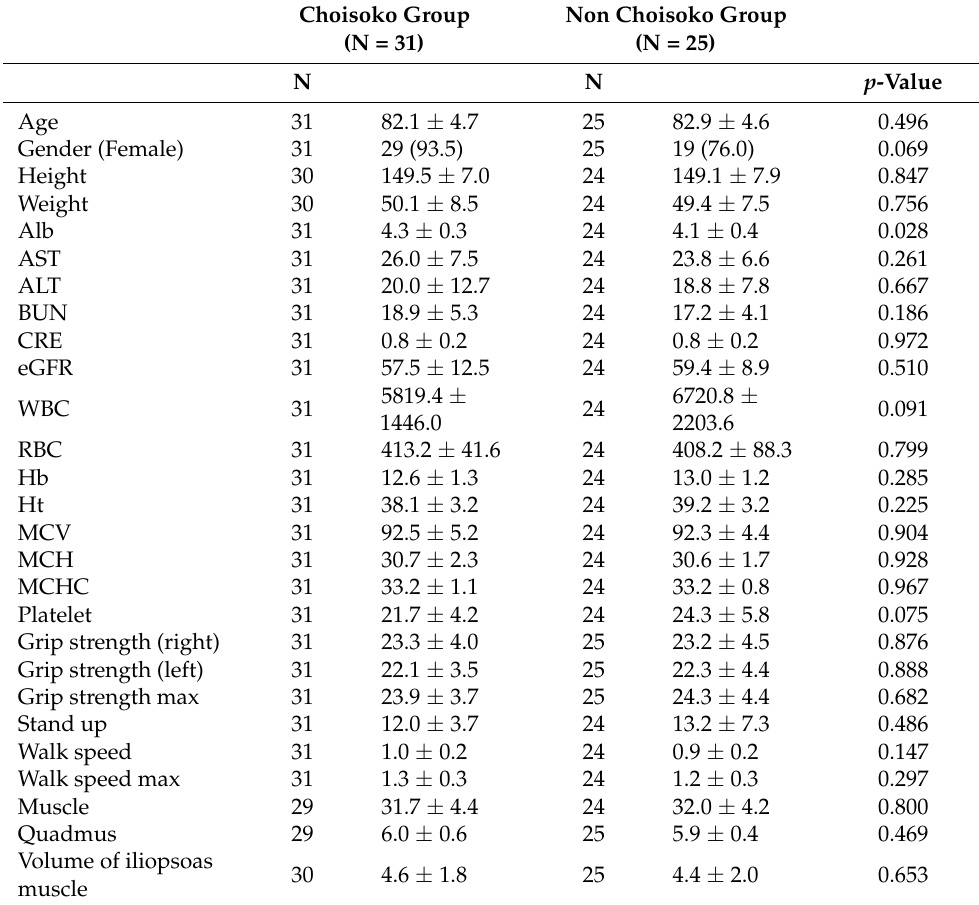
Table 1. Baseline